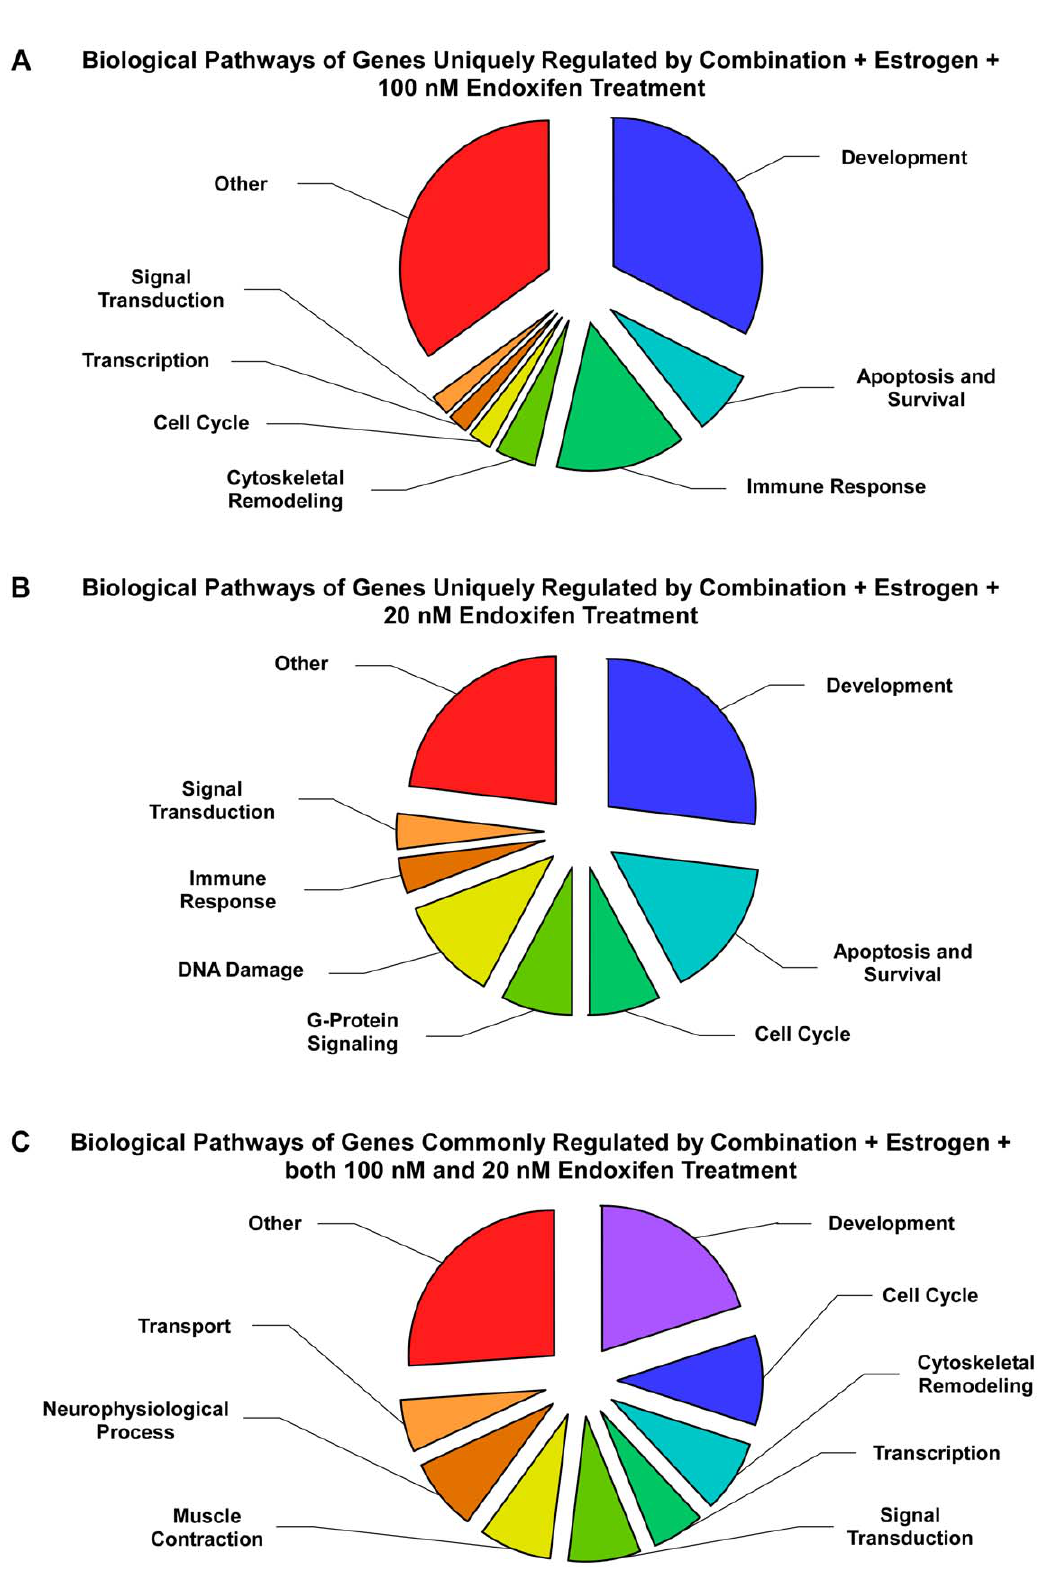
Figure 8. Pathway analysis of genes regulated by 100 nM or 20 nM endoxifen treatments in the presence of estrogen and physiologically relevant levels tamoxifen and its metabolites. The sub-categories of biological pathways determined to be significantly altered and which were unique to the 100 nM endoxifen treatment ( A ) or the 20 nM endoxifen treatment ( B ), or which were commonly regulated by both endoxifen concentrations ( C ), are shown. The specific biological pathways which are comprised within these sub-categories are listed in Table 1.